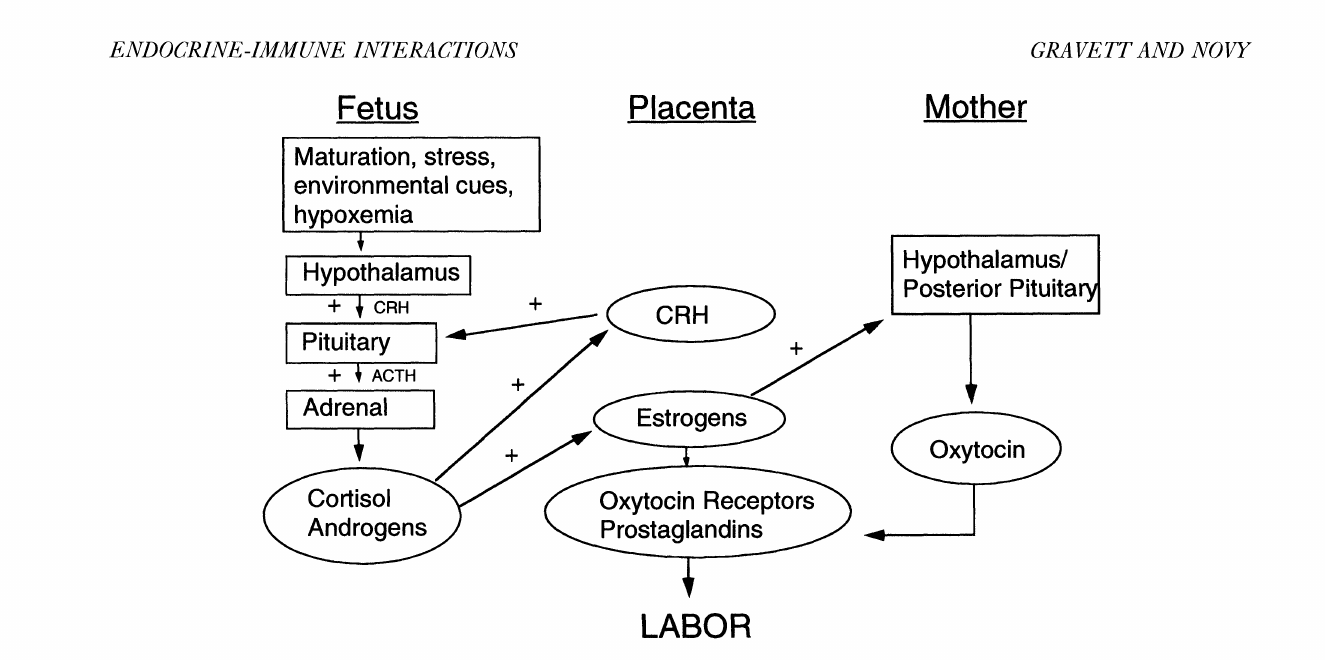
feedback loop to further stimulate placental CRH secretion. Fetal adrenal androgens are converted to estrogens by the placenta. These estrogens then stimulate maternal oxytocin secretion, myometrial oxytocin receptors, myometrial gap junction formation, and prostaglandin production. These events are necessary to facilitate uterine contractions and labor and are likely also modulated by